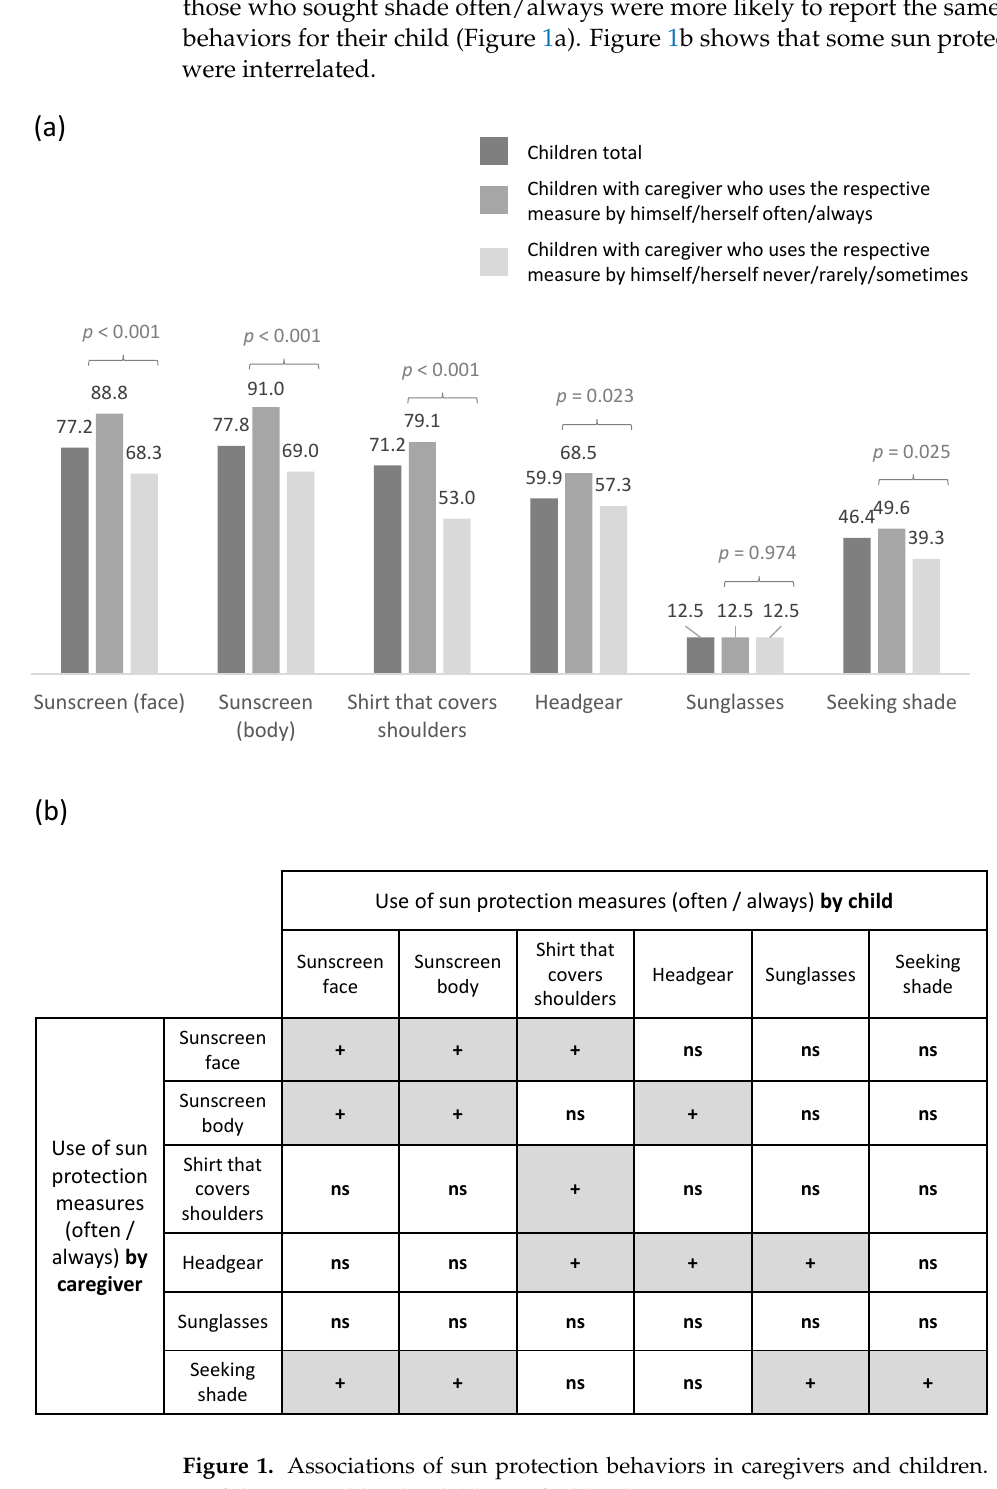
Figure 1. Associations of sun protection behaviors in caregivers and children. ( a ) Measures often/always used by the child stratified by the caregiver’s use. ( b ) Associations of measures used by the caregiver and those used by the child. +: chi-squared test was significant on p < 0.05 level of significance; ns: not significant